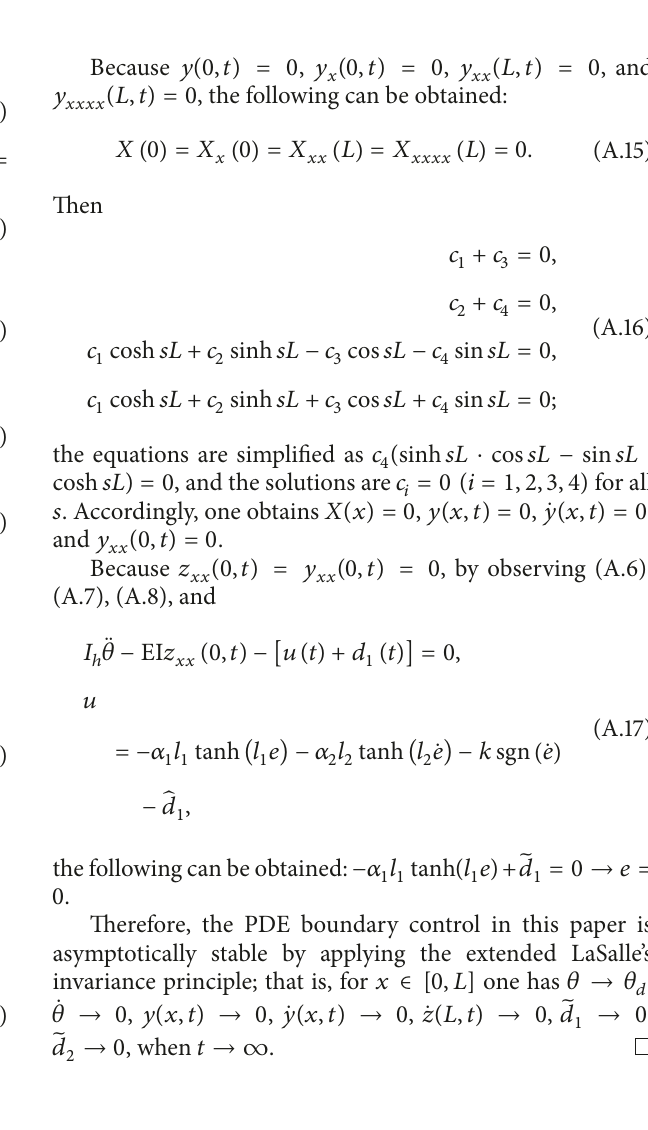
Figure 5: Comparison of the disturbance